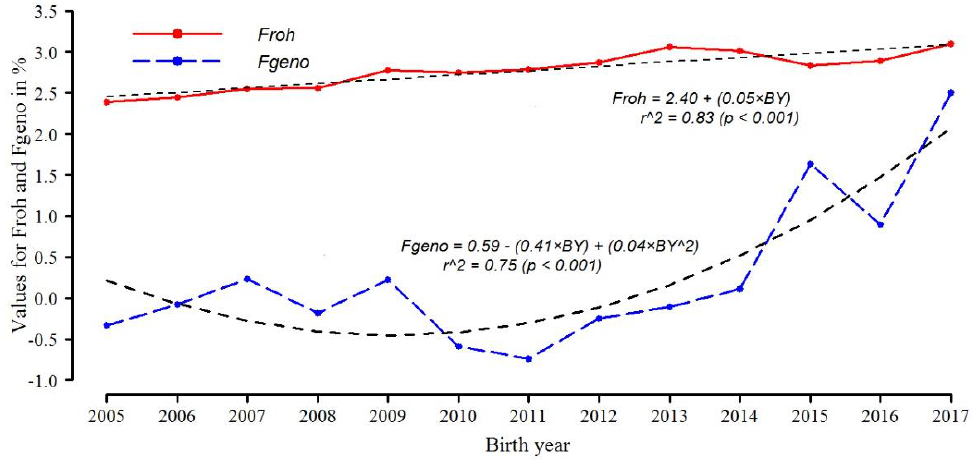
Figure 2. Distribution of inbreeding coefficients calculated by Runs of Homozygosity (Froh) and calculated by the number of homozygotic SNP markers observed and expected (Fgeno), from 2005 to 2017, with trend lines. BY: Birth year recoded from 1 to 13, BY^2: Squared recoded birth year.